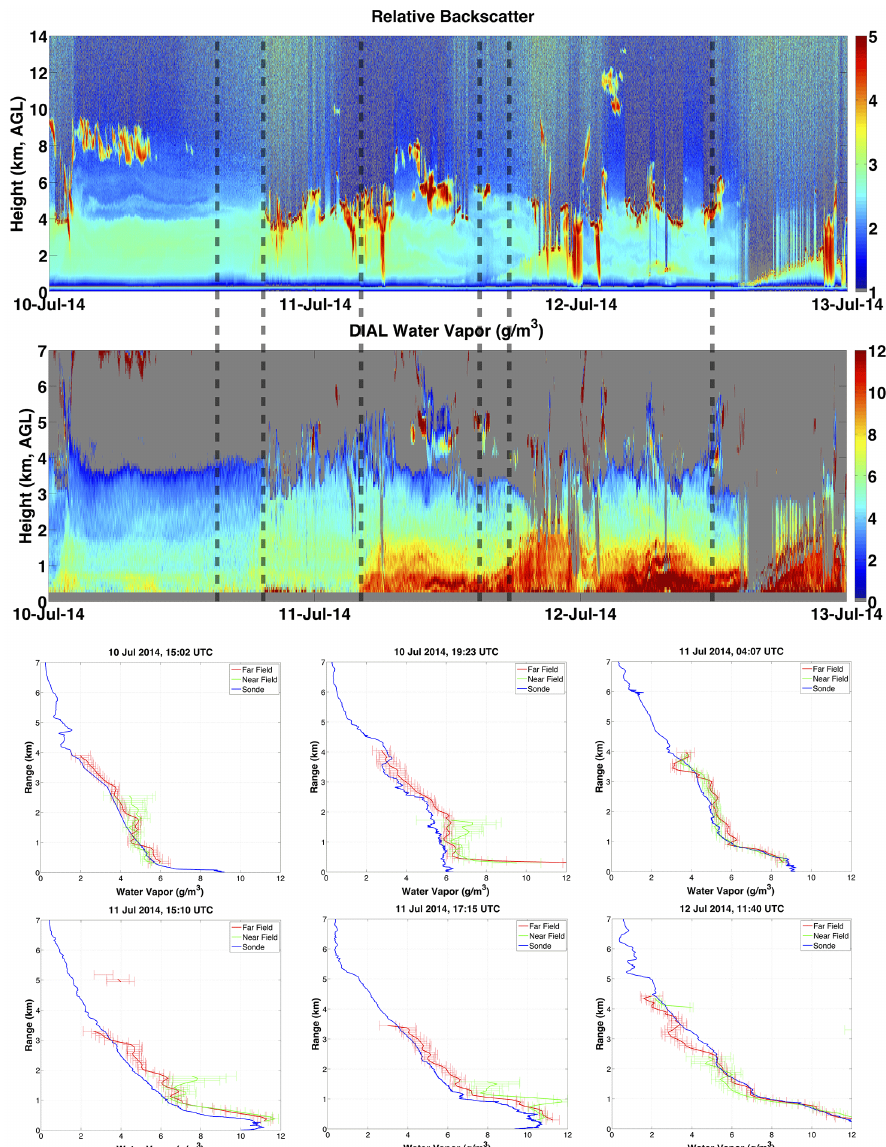
Figure 9. Top panel: 1min, 150m resolution relative backscatter from the range of 0–14km; middle panel: 1min, 150m resolution water vapor in gm − 3 ; 300 and 600m smoothing were applied to the data from 2 to 3km and above 3km, respectively. The dashed black lines overlain on the top and middle panels indicate times when sondes were launched. Bottom figures: individual water vapor concentration profiles for the sonde (blue) and WV-DIAL with 25min average profiles for far-range (red) and near-range channels (green) in gm − 3 .